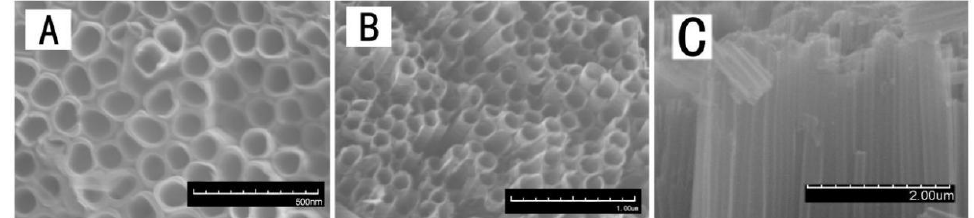
Figure 1. Scanning electron microscope images of anodized nanotubular titanium. The top view ( A , B ) and cross ‐ section ( C ) of the layers display an organized tube array with an average thickness of the layer of 4 μ m tube and an average diameter of around 80 nm.